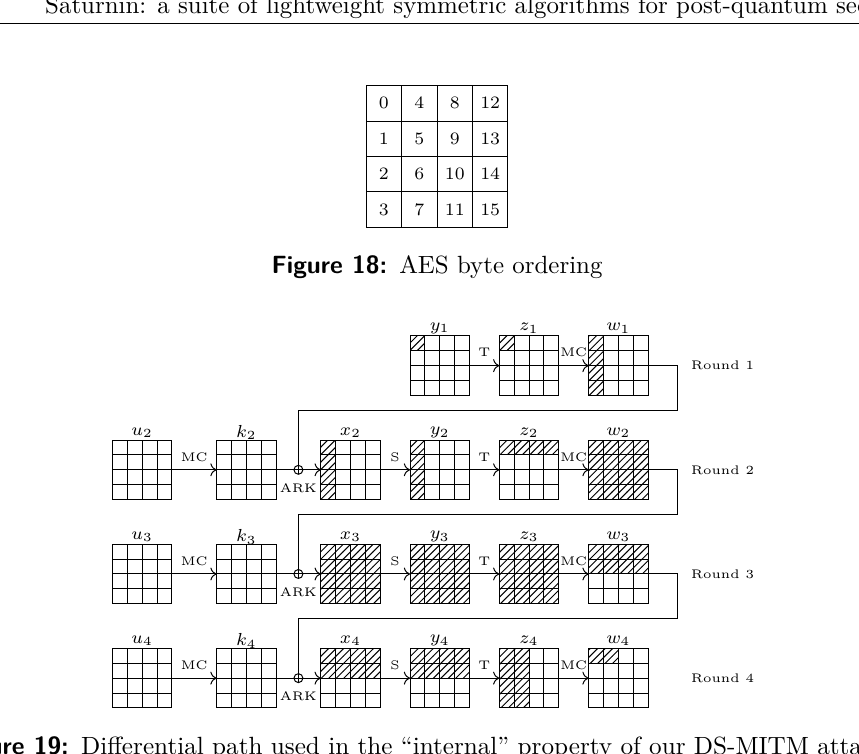
Figure 19: Differential path used in the “internal” property of our DS-MITM attack on 7.5-super-round Saturnin